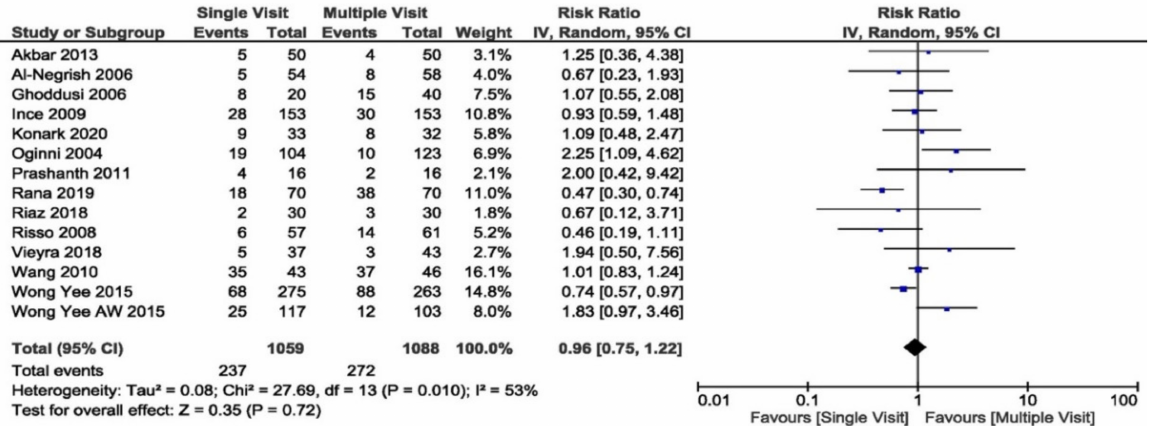
Figure 2. Meta-analysis summarizing the comparison of the incidence of a post endodontic pain and flareup between single and multiple visit root canal treatment